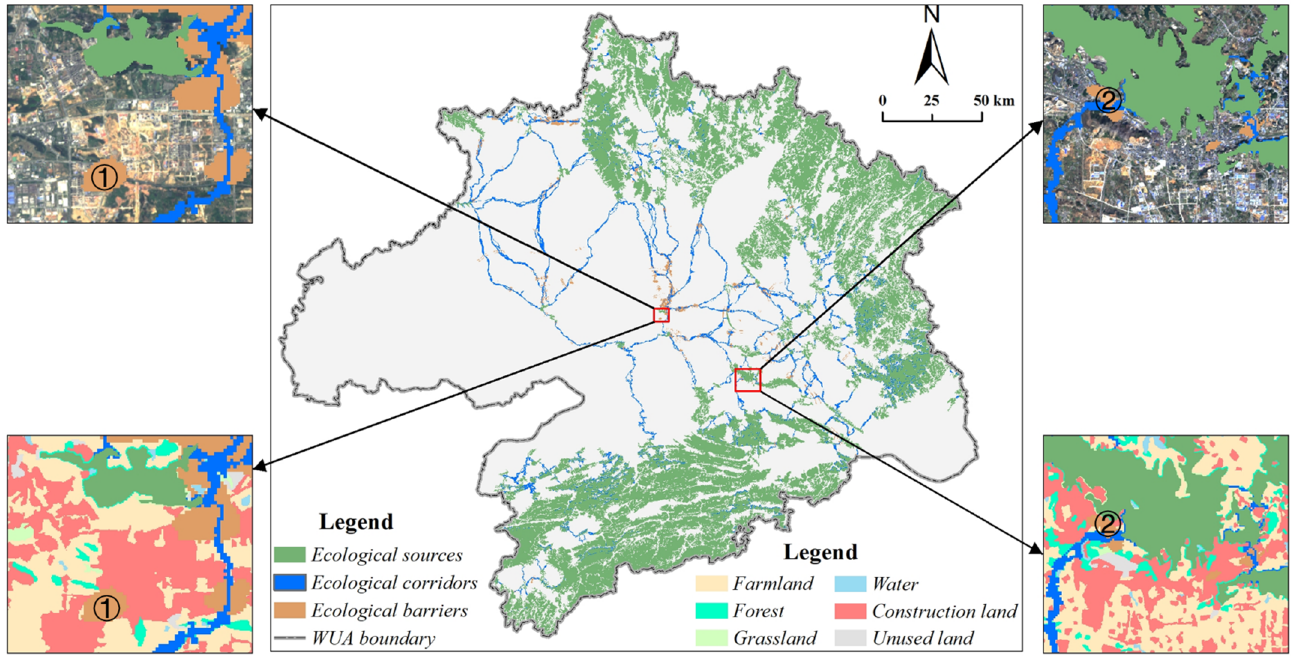
Figure A4. Verification of typical ecological barriers in 2020.